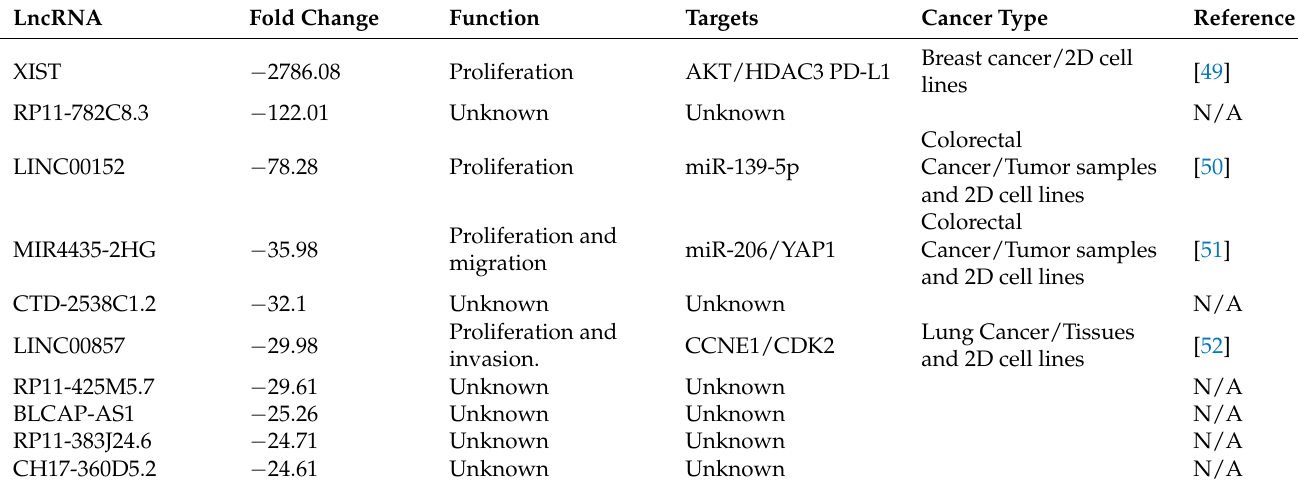
Table 2. Down-regulated lncRNAs in 3D